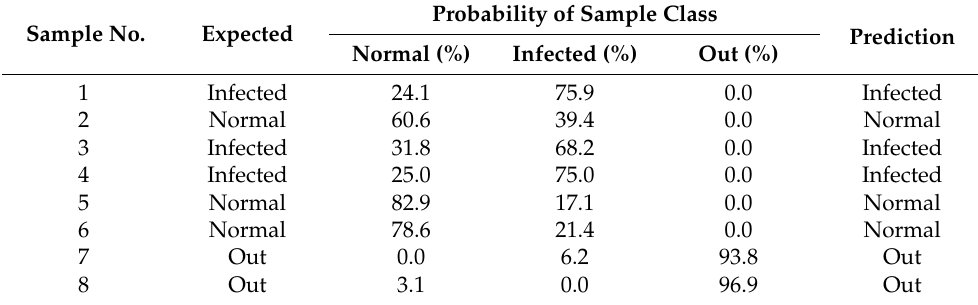
Table 3. Prediction results of blind samples.